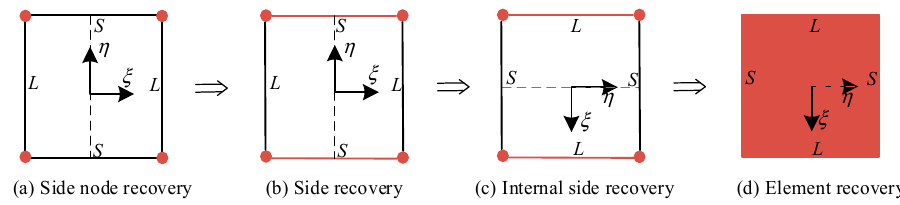
Figure 3. Element D-by-D recovery of 2D problems.